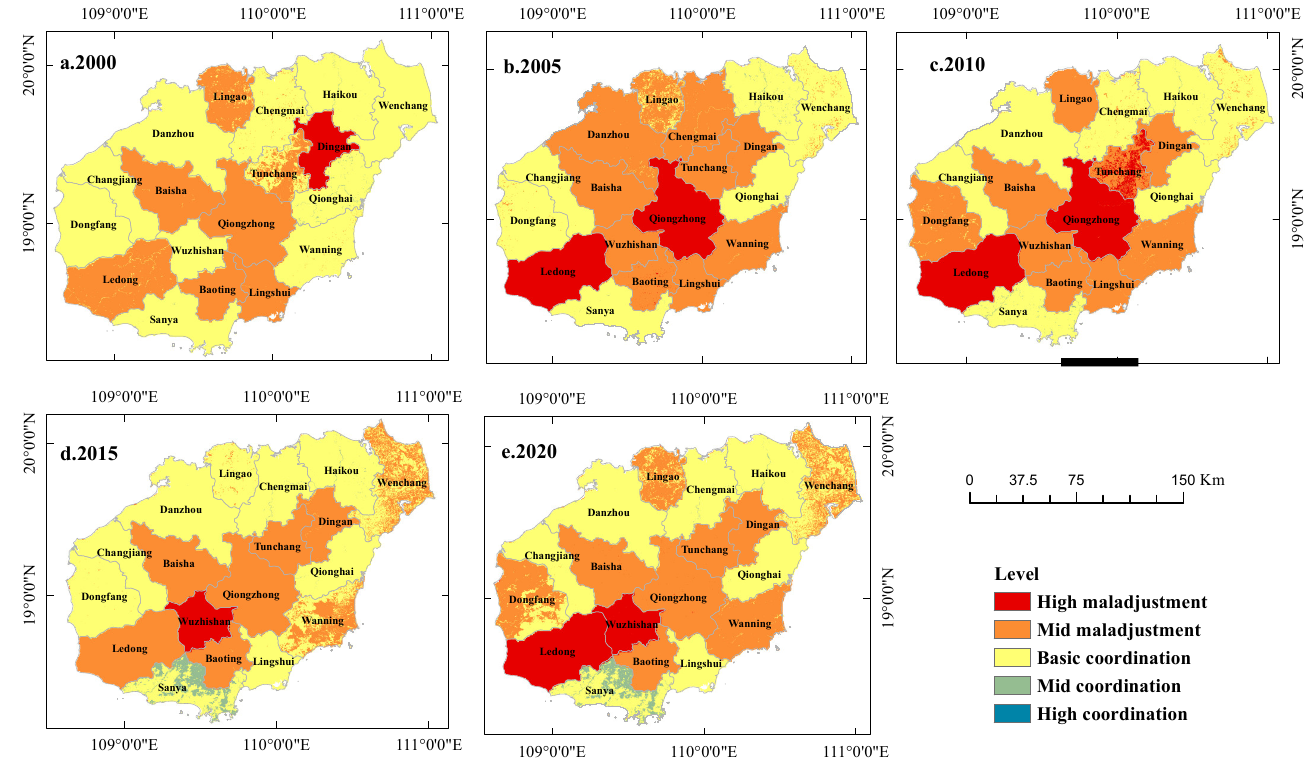
Figure 12. Spatial distribution map of the EEC in Hainan. ( a ) Spatial distribution map of the EEC in Hainan in 2000; ( b ) spatial distribution map of the EEC in Hainan in 2005; ( c ) spatial distribution map of the EEC in Hainan in 2010; ( d ) spatial distribution map of the EEC in Hainan in 2015; and ( e ) spatial distribution map of the EEC in Hainan in 2020. Table 12 shows counties and cities in ascending order of coordination. Sanya’s EEC Table 11. Area statistics of EEC level (km 2 was the highest in 2015 and 2020, Haikou’s EEC was the highest in 2005 and 2020, and Qionghai’s EEC was the highest in 2000. They were all in a basic coordinated state. Sanya, Haikou, Wenchang, and Changjiang were all in a basically coordinated state over the past 20 years, which showed that the GDP growth of these regions also improved the ESV.